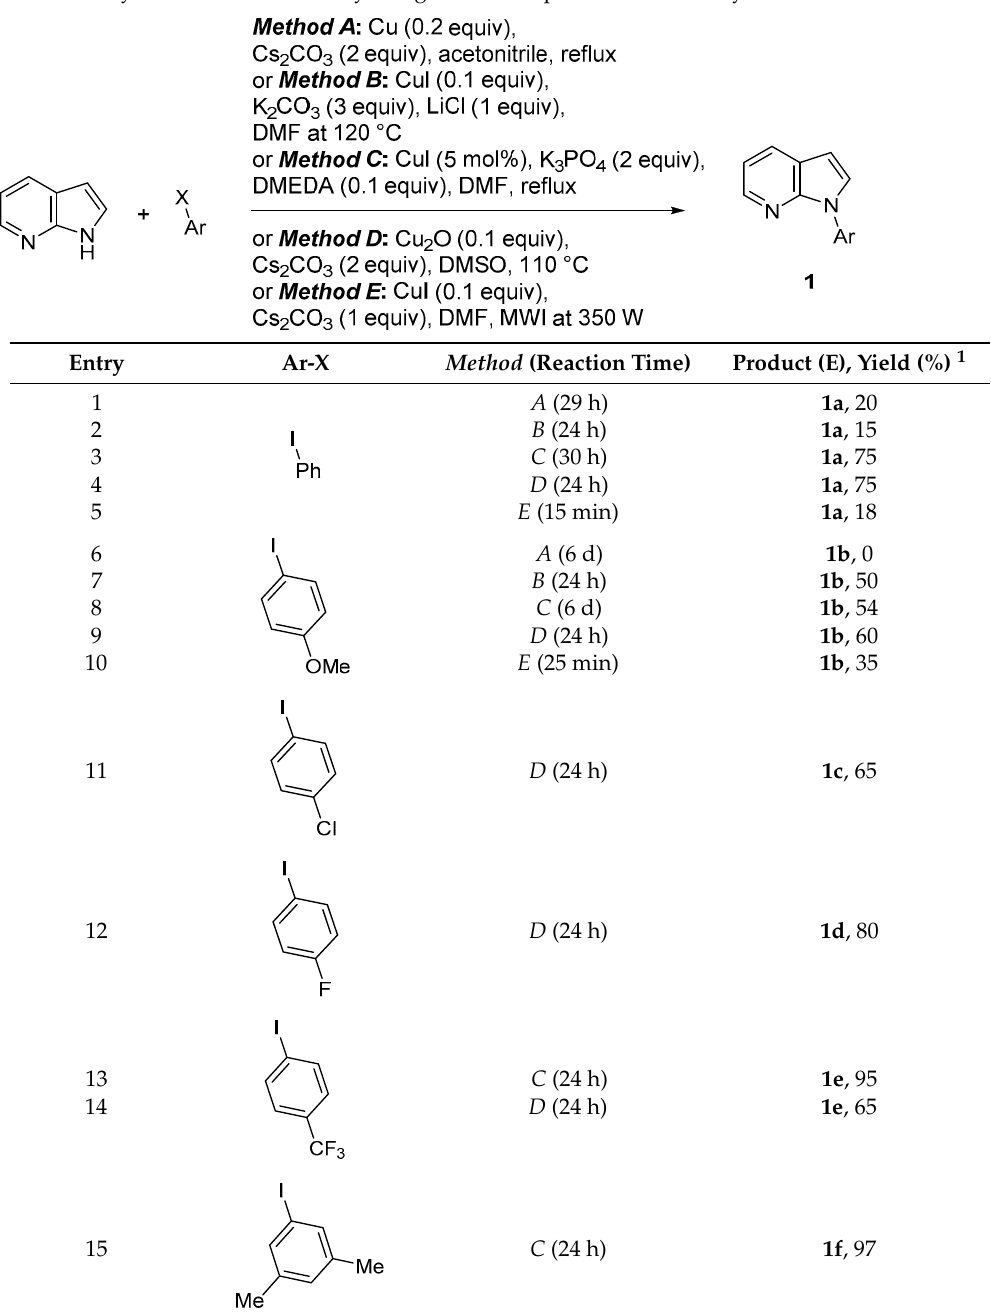
Table 1. 1-Arylation of 7-azaindole by using methods reported for the N -arylation of azoles.